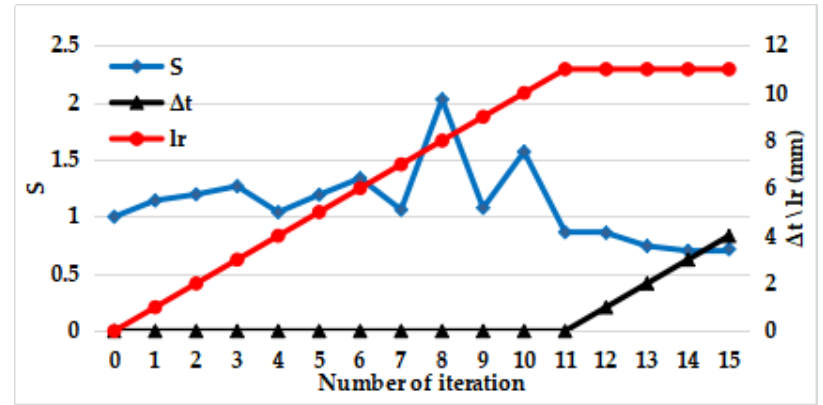
Figure 14. Iteration process of optimization algorithm used in rectangular coupler.